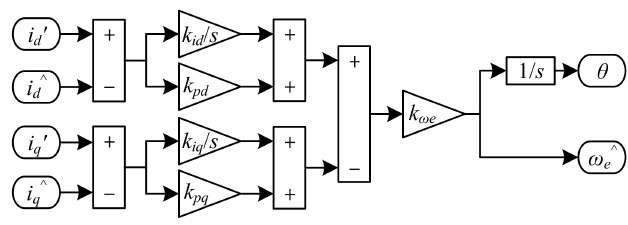
Figure 6. Diagram of the position observer of the